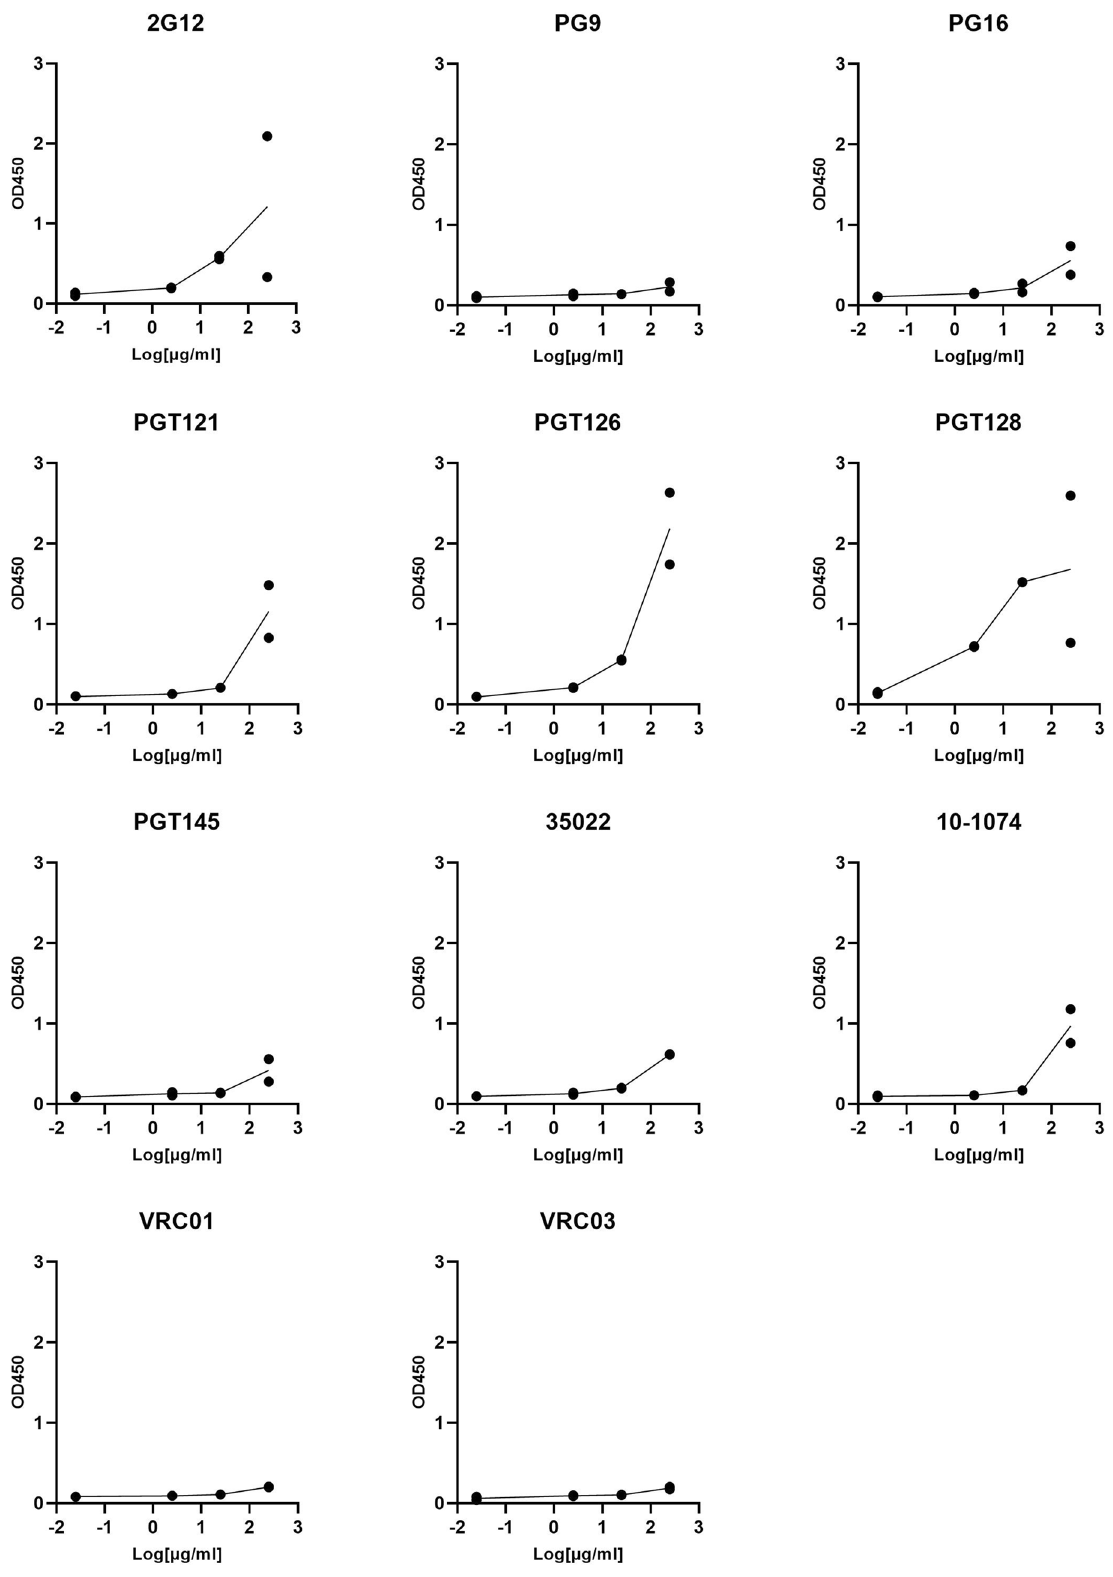
Figure 1. ELISA screen of glycan directed anti-gp120 antibody cross-reactivities to the SARS-CoV-2 Spike. Serial dilutions of the indicated mAbs were assessed for SARS-CoV-2 S protein binding. VRC01 and VRC03 target the CD4 binding site within gp120 and are included here as negative controls. All ELISAs were performed using BSA-based buffers (see methods). Experiments were done in duplicate and results are plotted as